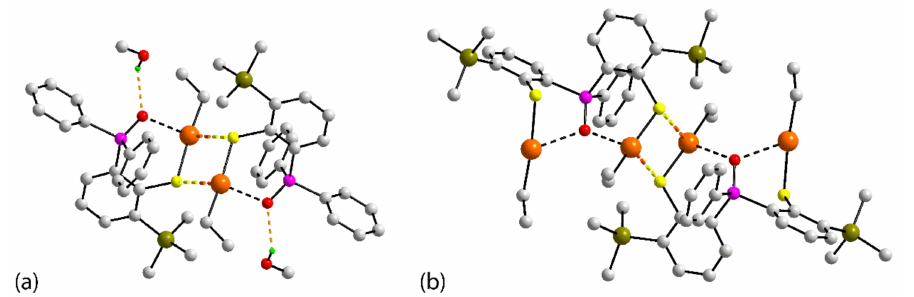
Figure 6. Supramolecular association in zero-dimensional aggregates featuring a { ··· HgS} 2 synthon: ( a ) 22 and ( b ) 24 . The intramolecular Hg ··· O contacts are indicated by black dashed lines and the O–H ··· O hydrogen bonds are shown as orange dashed lines. Additional colour code: dark-yellow—